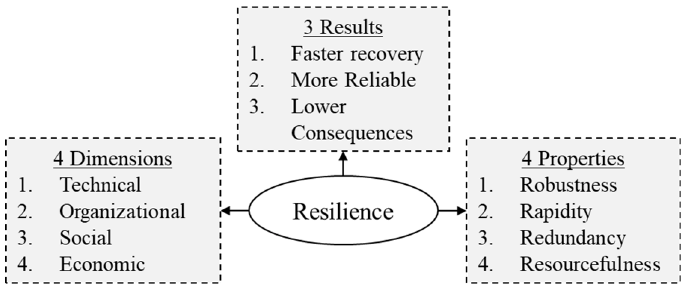
Figure 4. Aspects of resilience [1,36].